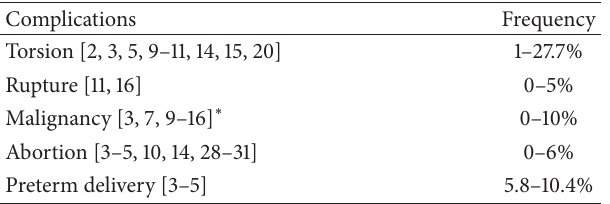
Table 5: Frequency of complications of adnexal masses in preg-